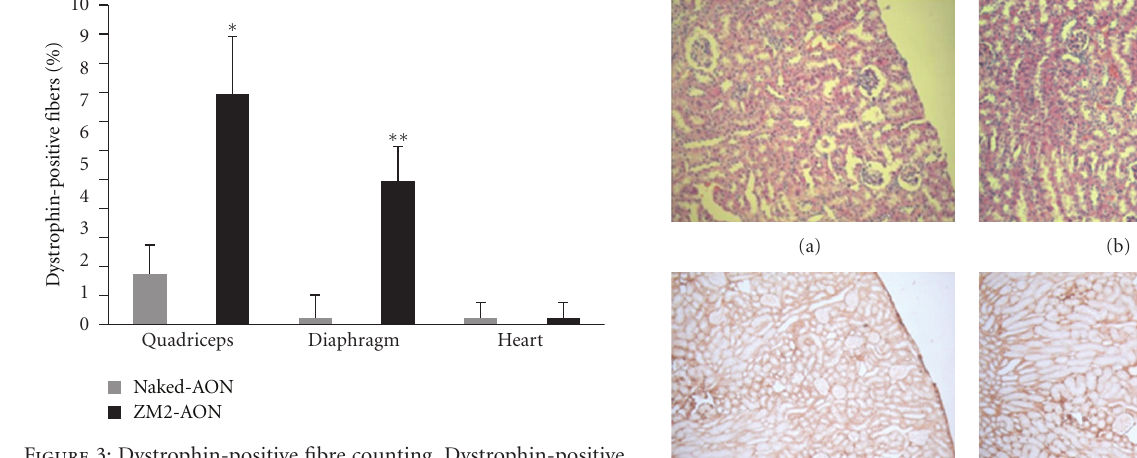
Figure 3: Dystrophin-positive fibre counting. Dystrophin-positive fibre counting was performed on fibres with a labelling that covers at least 80% of the sarcolemma perimeter. Images were recorded and processed using identical exposure parameters. The graph shows the percentage of dystrophin-positive fibres detected in the muscles and heart from ZM2–AON- (black columns) and naked AON-treated (grey columns) mdx mice, calculated with respect to untreated mice, on sections representative of the total muscle. Quadriceps and diaphragm from ZM2–AON-treated mice show significantly higher percentages of dystrophin-positive fibres (7.2% in quadriceps and 4.5% in diaphragm) than the same muscles from mice treated with naked AON (reminiscent of untreated mdx mice). Negligible levels of dystrophin-positive fibres were detected in the heart of both treatment groups. Percentages of positive fibres in muscles from treated mice (ZM2-AON and naked AON) were calculated by subtracting the percentages detected in untreated mdx mice (up to 3%), considered as baseline (% positive fibres in treated mice − % positive fibres in untreated mice). The significance was calculated with respect to naked AON-treated mice (error bars represent mean ± S.E.M., n = 10, t -test, and ∗ P < 0 . 05, ∗∗ P < 0 . 001).